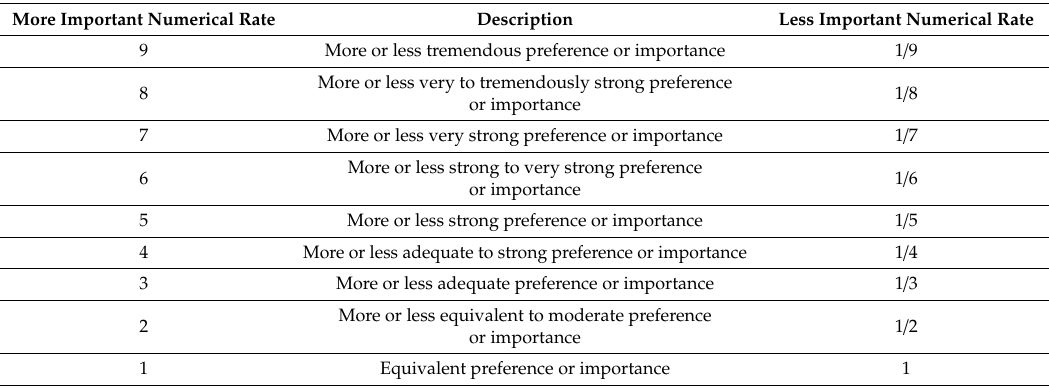
Table 2. The pair-wise comparison of criteria importance values and their mathematical proportions [35]. More Important Numerical Rate